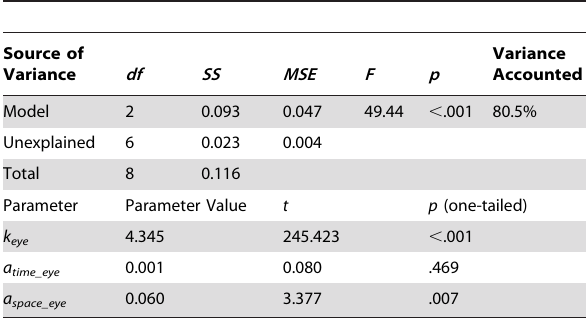
Table 1. Regression results from the least-squares fit of Eq. 2 to the eye fixation duration data.